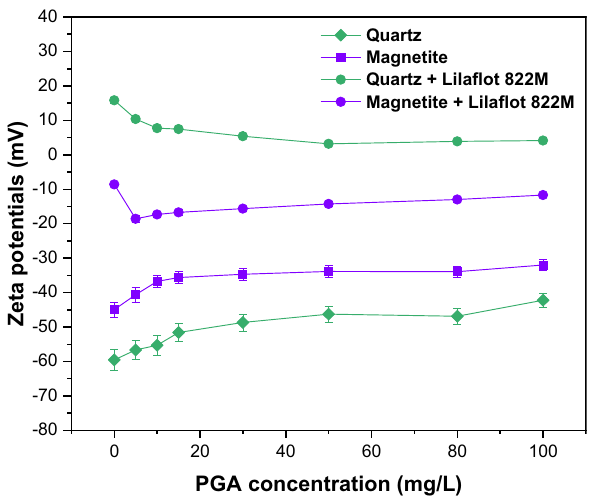
Figure 7. Zeta potentials at varying PGA concentration with fixed Lilaflot 822M (50 mg/L) and pH.